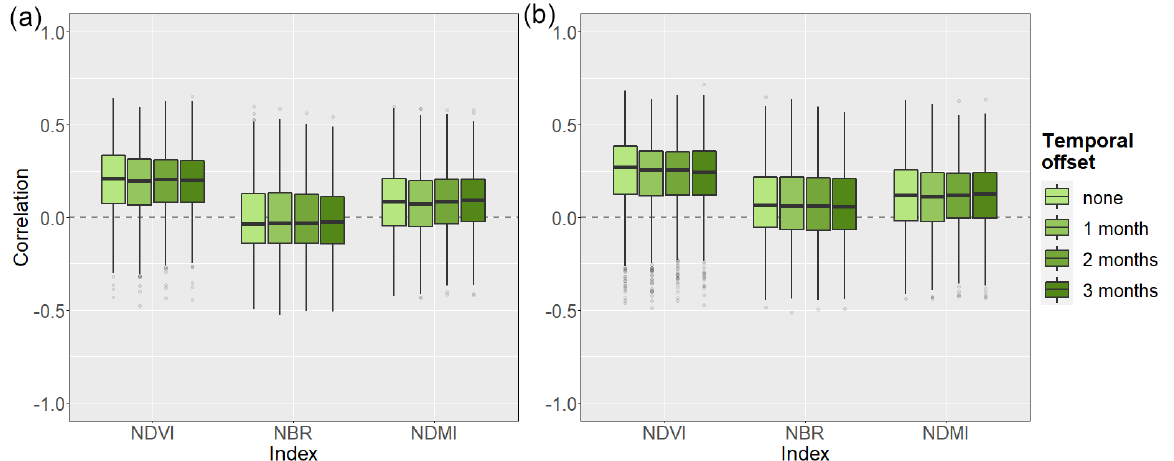
Figure 5. Boxplots of correlation scores between monthly scPDSI values and MODIS ∆ Harmonic ( a ) as well as z-score ( b ) values. NDVI outperformed the other two indices for both ∆ Harmonics ( a ) and z-score ( b ) data. z-score generated overall slightly higher r values.